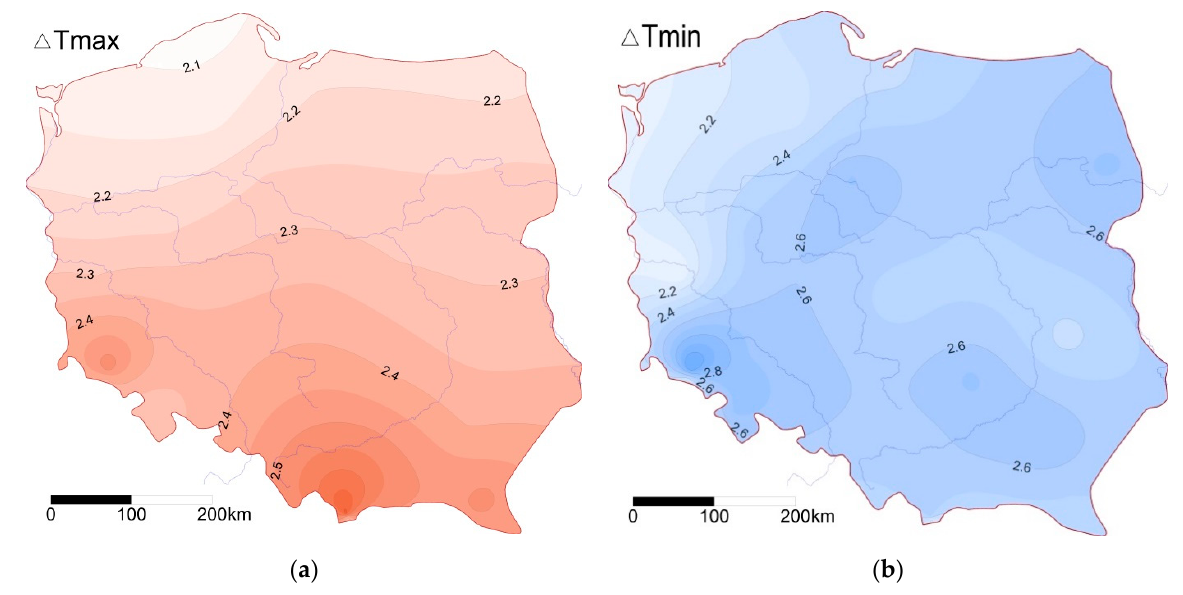
Figure 2. Average annual day-to-day changes of Tmax ( a ) and Tmin ( b ) in Poland in the years 1966–2015.